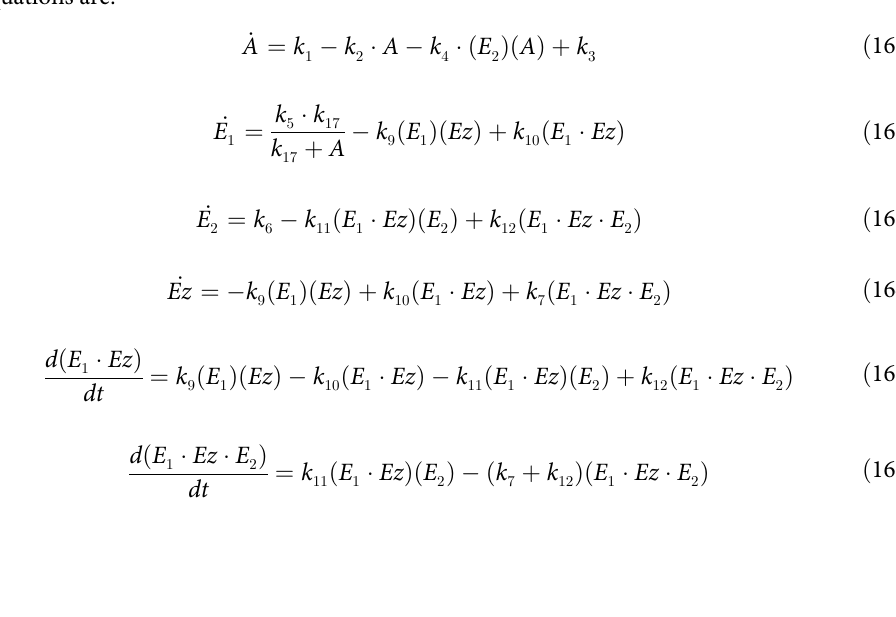
Motif 7 controller using compulsory-order ternary-complex mechanisms. As for the other ternary-complex controller motifs there are two compulsory-order mechanisms, one in which E binds first to free Ez (Fig 56a), while in the other one (Fig 56b) E binds first to Ez . 1 2 The two compulsory-order mechanisms behave quite similar compared with the random- order mechanism. In the case when E is binding first to the free enzyme Ez (Fig 56a), the rate 1 equations are: